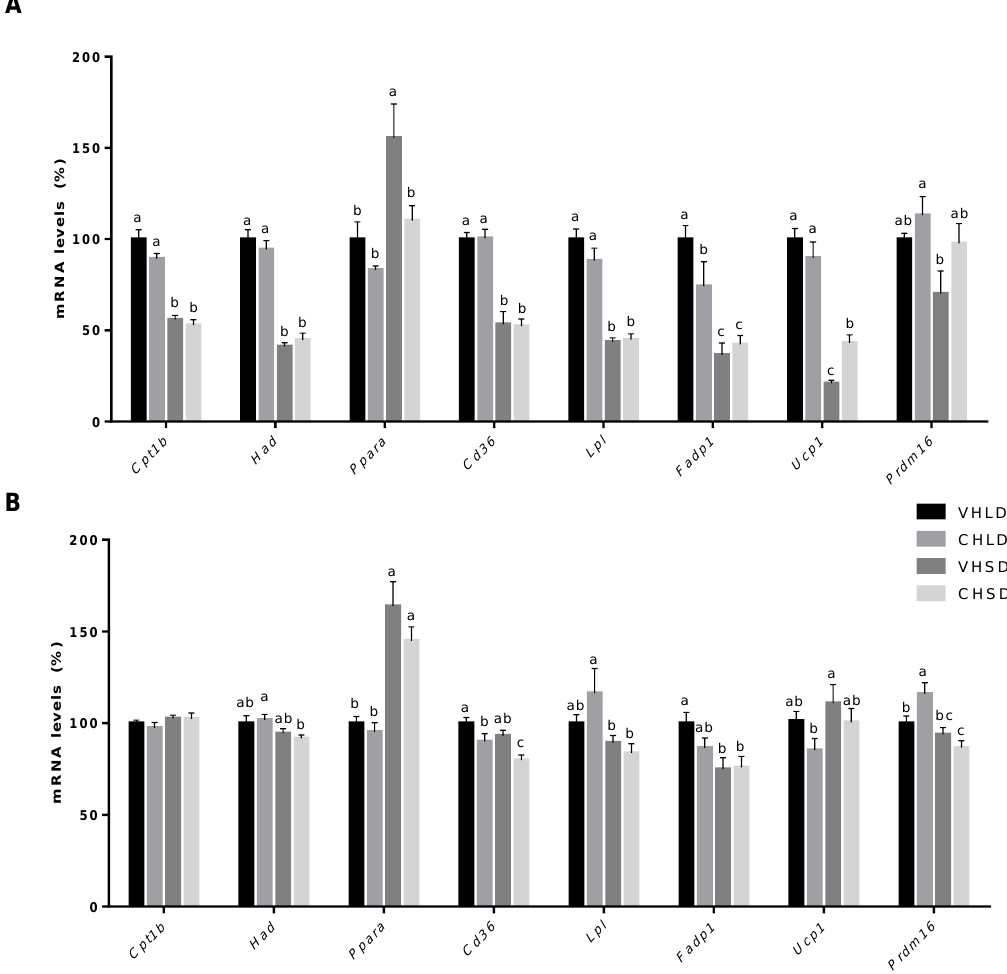
Figure 4. mRNA expression levels in BAT of Fischer 344 rats supplemented with a cherry (CH) lyophilizate or vehicle (VH), held in long-day (LD) and short-day (SD) photoperiods, and fed either with an STD ( A ) or a CAF ( B ) diet in two independent experiments. Expression of genes related to lipogenesis, lipolysis, adipogenesis, and thermogenesis. Data are presented as the ratio of gene expression relative to the β-actin , Ppia , and H prt genes and expressed as a percentage of the LD group set at 100%. Data are presented as the mean ± SEM, and the four groups are compared with a one-way ANOVA test ( p < 0.05) followed by a Duncan’s new multiple range test (MRT) post hoc test. abc Mean values with unlike letters differ significantly among groups.